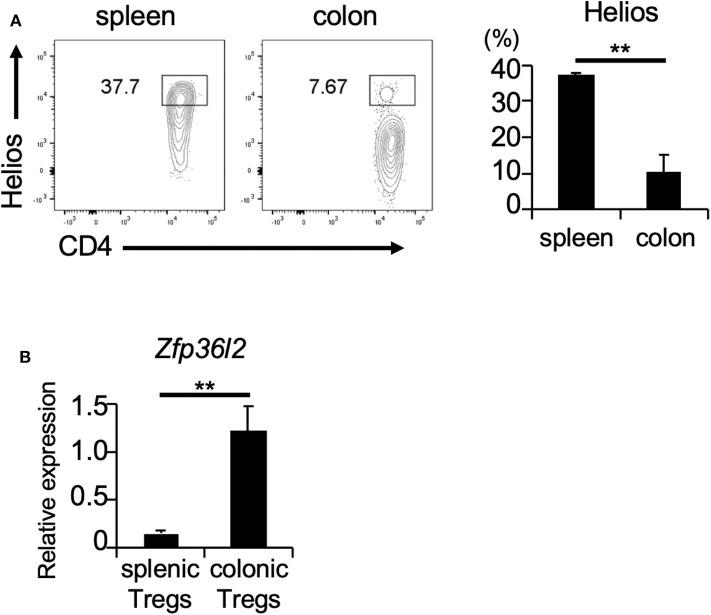
Zfp36l2 expression is inversely correlated with Helios expression in Tregs. (A) CD4+ YFP+ Tregs were isolated from the spleen and colon of Foxp3YFP−Cre mice. Representative CD4 vs. Helios staining of CD4+ YFP+ cells and the frequency of CD4+ Helios+ cells are shown. Data are means ± SD (n = 3, each), **p < 0.005, representative of two independent experiments. (B) Total RNAs were prepared from CD4+ YFP+ cells in spleen and colon of Foxp3YFP−Cre mice, and mRNA levels of Zfp36l2 were analyzed by qPCR analysis. Data are means ± SD (n = 3, each), **p < 0.005, representative of two independent experiments.